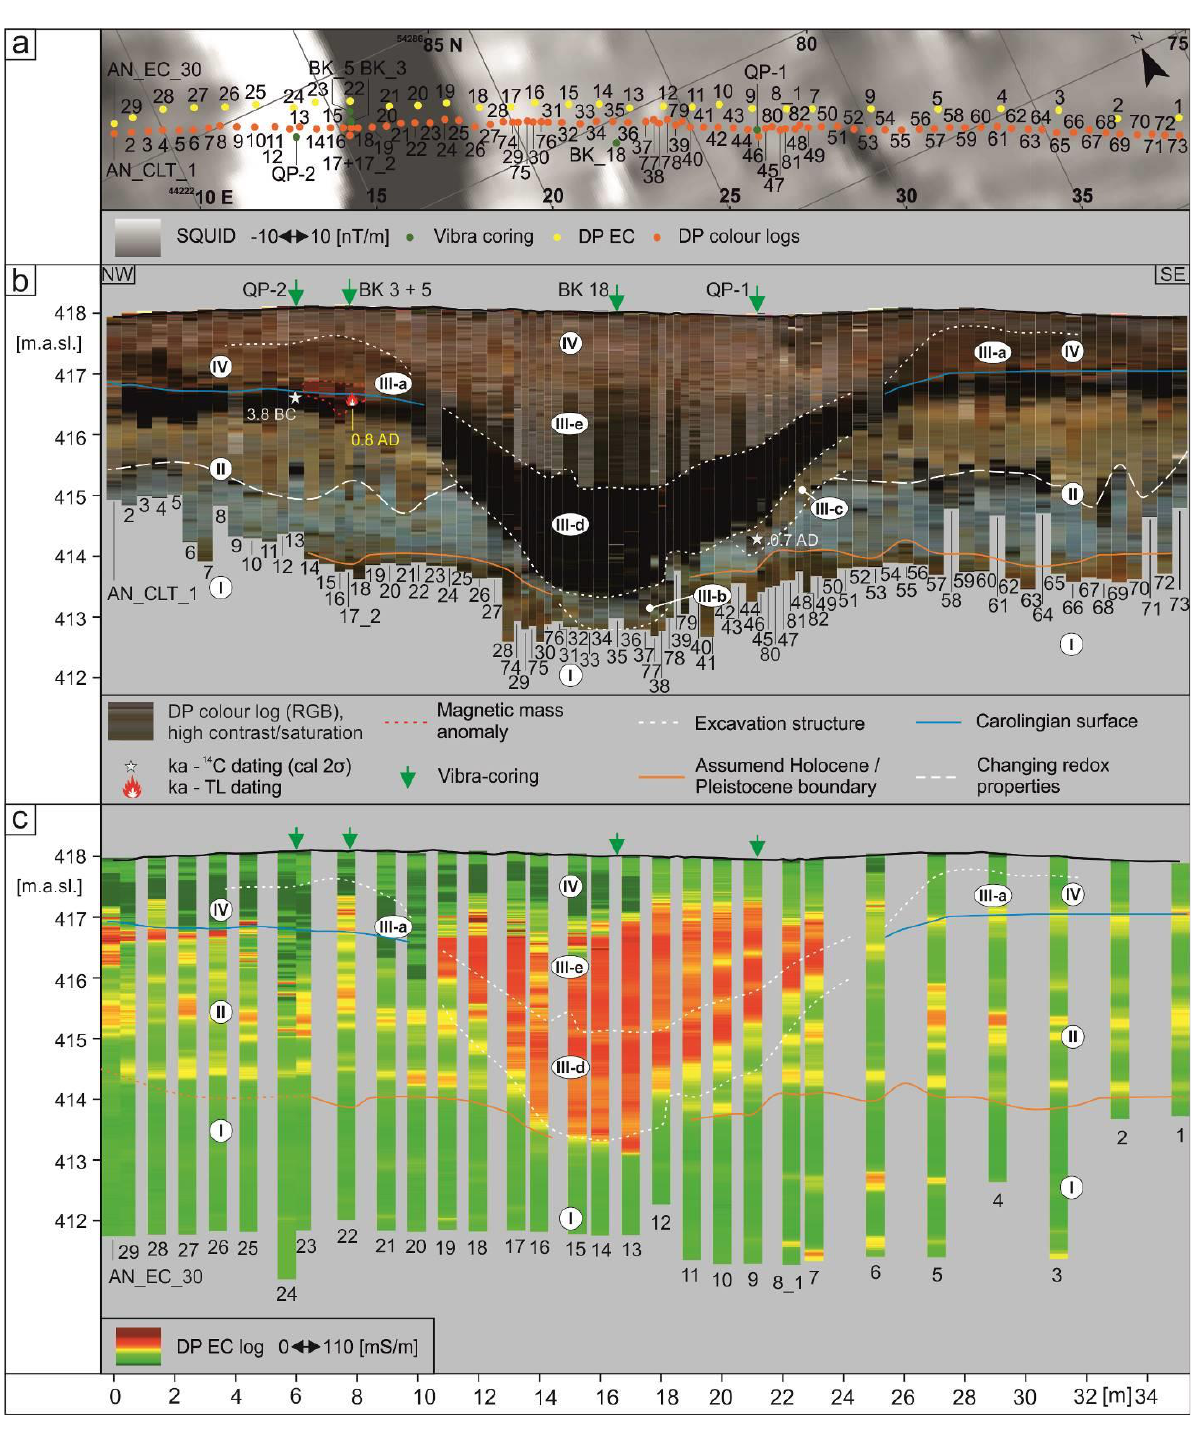
Figure 7. Investigations at the Fossa Carolina by high-resolution direct push cross-section. ( a ) Map showing the location of the direct push logs and vibracoring. Cross-sections show the results of ( b ) the colour logs and ( c ) the electrical conductivity logs. Sediment units are described in the text.